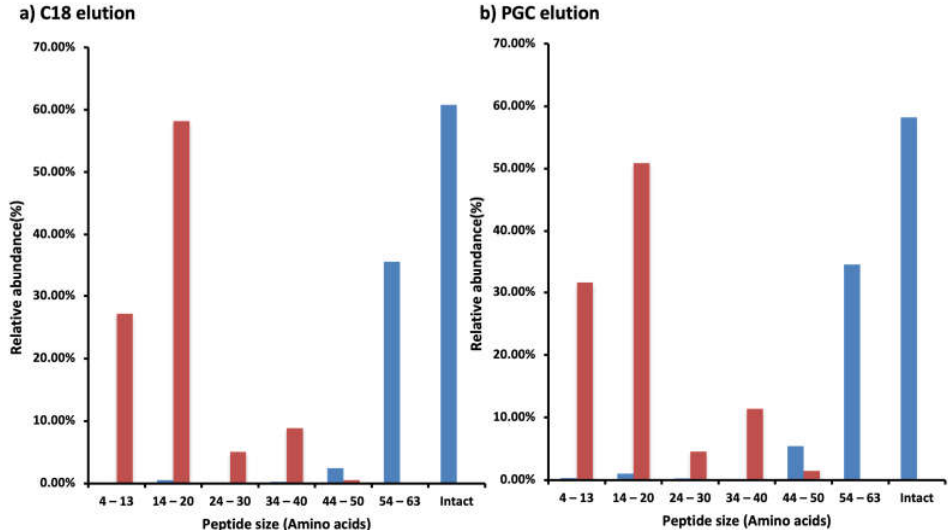
Figure 5. Bar graphs of the relative abundance of CMP and CMP-derived peptides based on peptide size (based on counts of amino acids) found in the WPI (blue) or the intestinal digestive sample (red) in the ( a ) C18 SPE or ( b ) PGC elution fractions. Relative abundances were calculated from the sum of peak abundances of the CMP and/or CMP-derived peptides in the labeled range of peptide size divided by the total peak abundances of the CMP and/or CMP-derived peptides in the WPI or the intestinal digestive sample in the fraction.